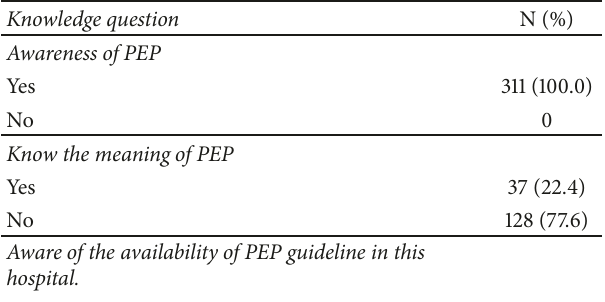
Table 2: Knowledge about PEP for HIV among healthcare workers in Hiwot Fana Specialized University Hospital, 2016.